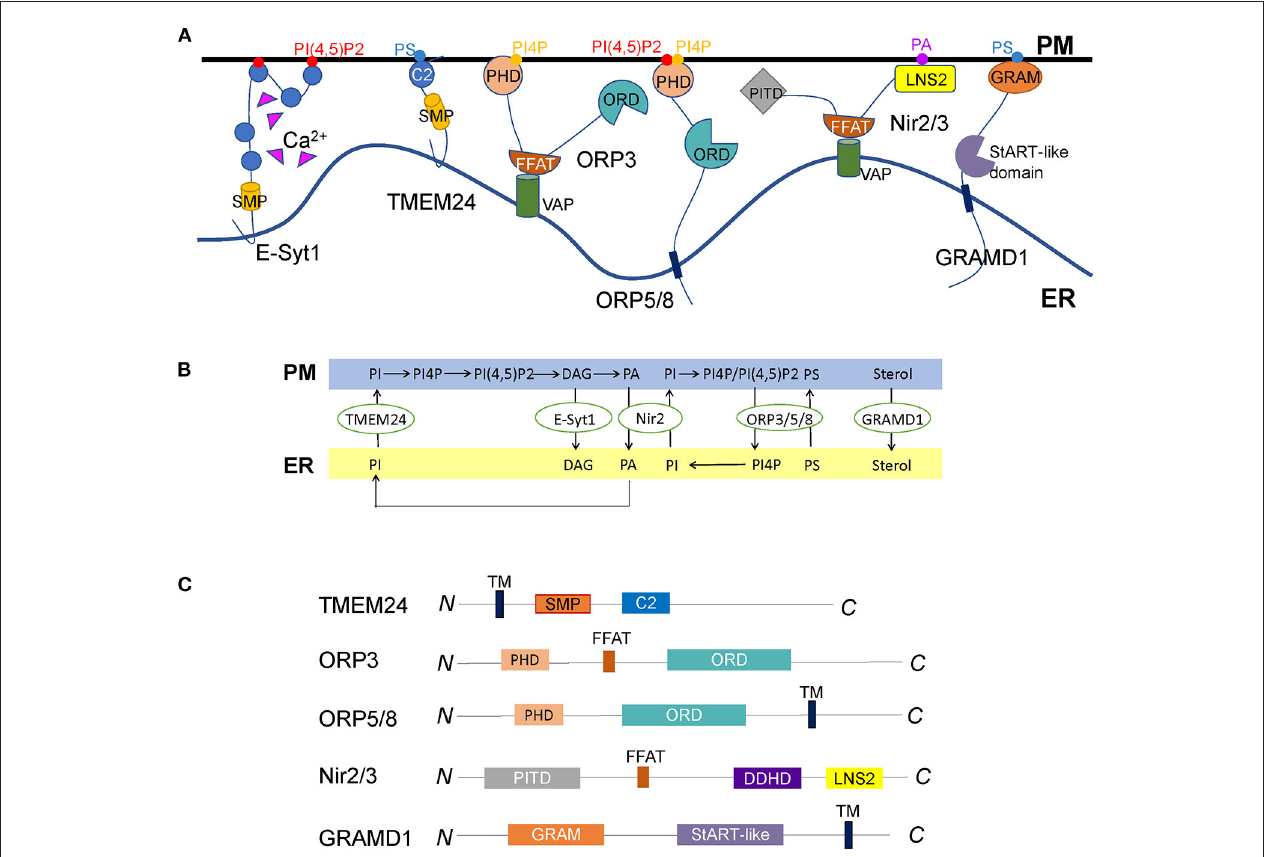
FIGURE 4 | Diverse LTPs functioning at the ER-PM contact sites. (A) Representative illustration of LTPs located at the ER-PM junctions. E-Syt1 transfers phospholipids and DAG directly through the SMP domain between the ER and the PM, regulated by interactions of the C2 domains with Ca 2 + . TMEM24 is another SMP domain protein localized to the ER through a transmembrane domain. It transfers PI from the ER to the PM controlled by the dephosphorylation of the C-terminal polybasic region. Whether other SMP domain proteins, for example, E-Syt2/3 and tricalbins, mediate lipid transport at ER-PM contact sites remains unknown. ORP3, ORP5, and ORP8 are so far discovered ORPs at ER-PM contact sites. While ORP5 and ORP8 are ER membrane proteins, ORP3 is anchored to the ER through the interaction of its FFAT motif with VAP. All the three ORPs contain a PHD to interact with the PM lipids and an ORD to exchange PI(4)P/PI(4,5)P2 and PS between the ER and the PM. It remains elusive why the cell has three ORPs at ER-PM contact sites to mediate the same lipids. The discovery of the initial triggers of these LTPs might solve this problem. Nir2 and Nir3 are anchored to the ER via interactions of FFAT motifs with VAPs and connect to the PM by LNS2 domains, facilitating the PI and PA exchange between the two membranes. How other tethering molecules, such as E-Syts and Kv2s, couple with Nir2/3 to mediate PA/PI exchange need to be further explored. GRAMD1s are anchored to the ER via a C-terminal transmembrane domain and interact with cholesterol and PS on the PM through the N-terminal GRAM domain to connect the two opposed membranes. Thus, the accessible cholesterol is transported from the PM to the ER by StART-like domains. Whether there are other sterol transfer proteins transporting PM cholesterol to the ER or other organelles remains to be discovered. (B) The summary of LTPs-mediated lipid exchange at ER-PM contact sites. (C) Diagrams of the lipid transfer proteins described in A, except E-Syt1, are shown in Figure 1B . The major functional domains are shown in each of the